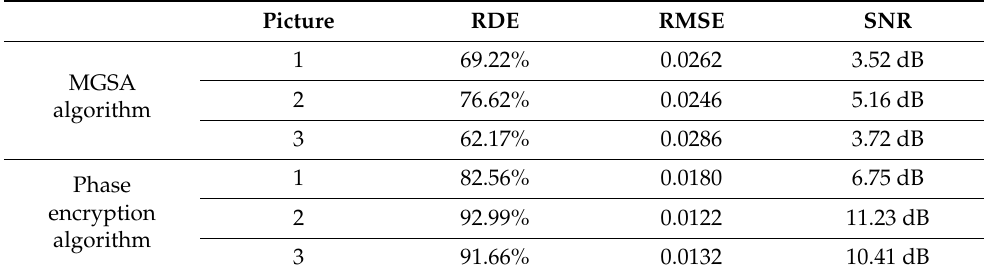
Figure 8. Results of coaxial reconstruction with distinct depth ( a ) with phase-locked algorithm and ( b ) without phase-locked algorithm. Table 1. Assessment results of reconstruction images simulated with multi-depth phase encryption